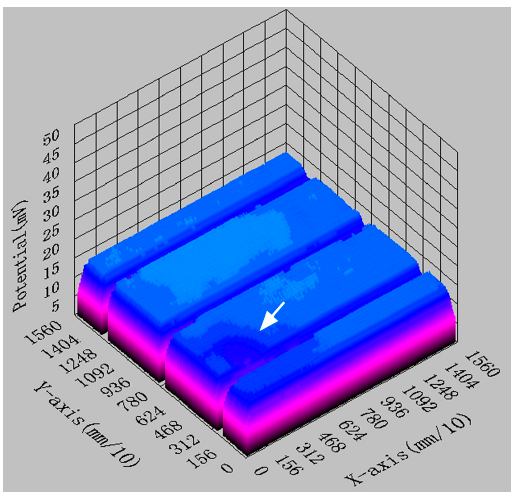
Figure 7. Image of shunting behavior of the mc-Si solar cell containing a minicrystallized region.